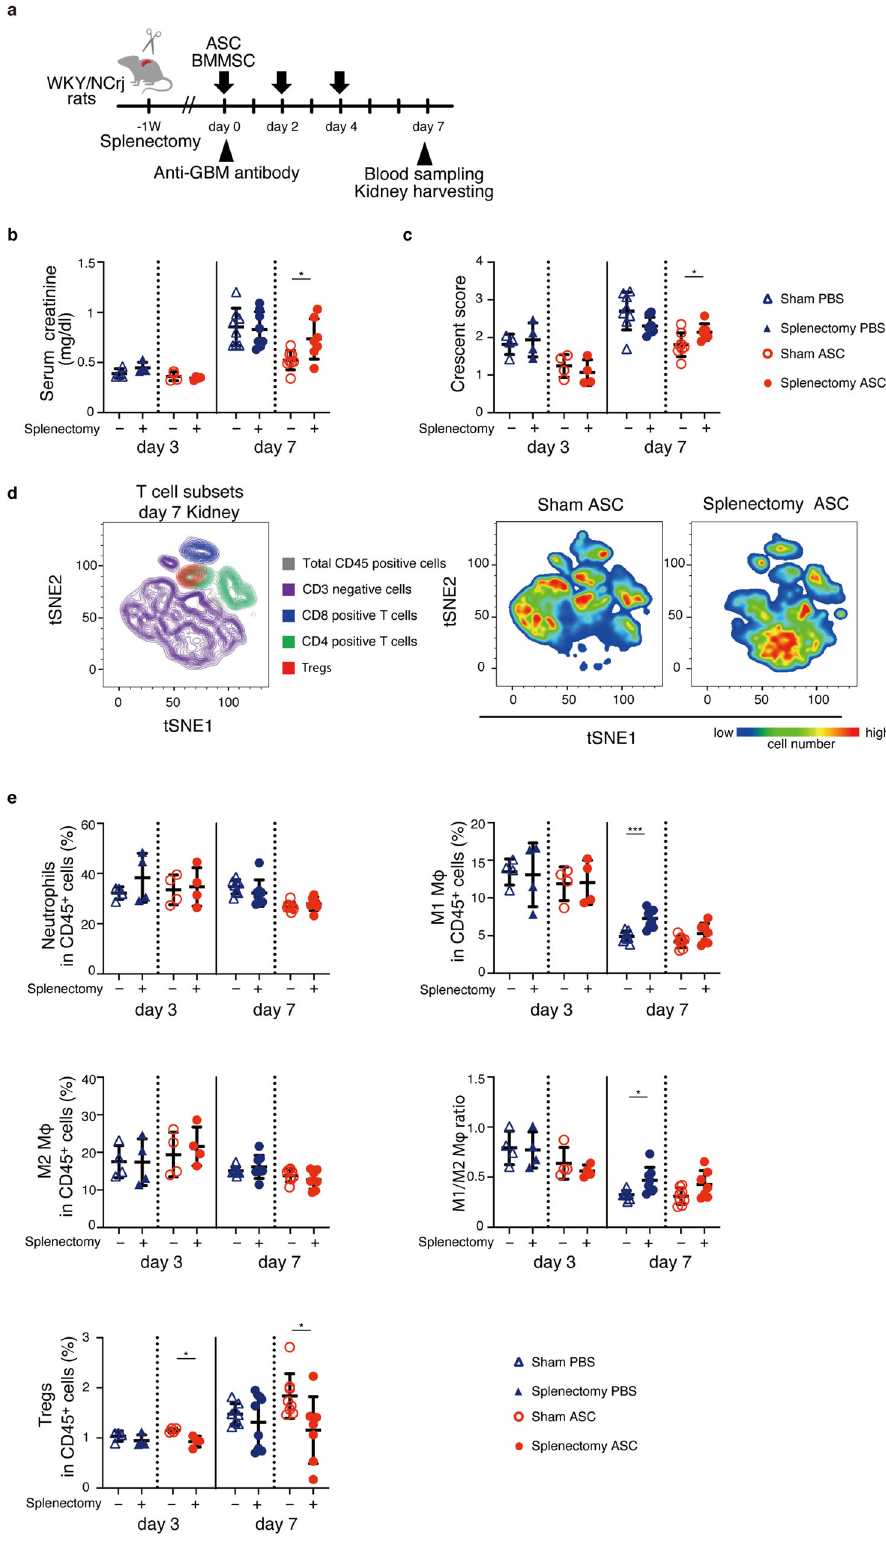
Fig. 4 Splenectomy abolished the therapeutic potential of ASCs. a Experimental scheme for analyzing the therapeutic potential of ASCs in rats treated with splenectomy. The rats underwent splenectomy 1 week before the nephrotoxic antibody injection. ASCs were administered on days 0, 2, and 4. b , c Serum creatinine level and histological crescent score on days 3 and 7 with and without splenectomy in each MSC treatment. d The tSNE plot shows the renal T-cell subset on day 3. e Frequency of renal leukocyte subsets in CD45 + cells analyzed by fl ow cytometry on days 3 and 7 (day 3, n = 4 per group; day 7, n = 7 – 8 per group). All data are shown as means ± SD. * p ≤ 0.05, *** p ≤ 0.001 as determined by Welch ’ s t